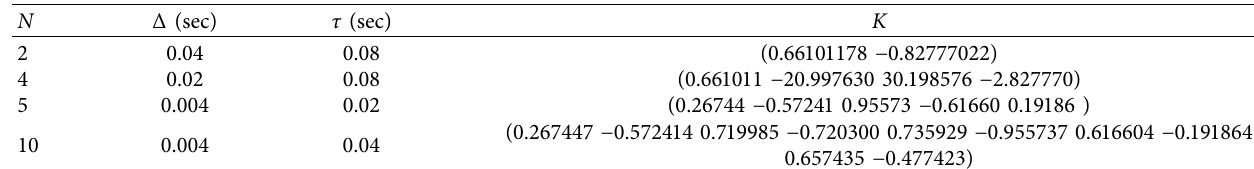
Table 2: Optimal K matrix values for given τ .